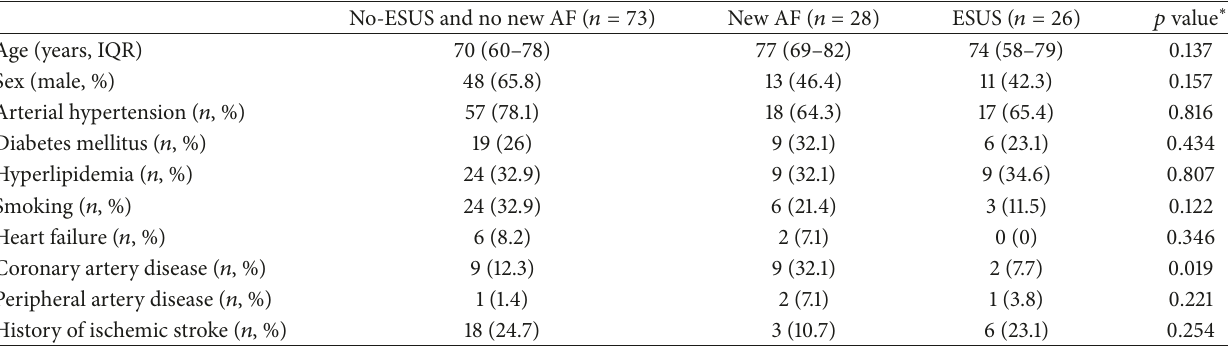
Table 1: Baseline characteristics ( 𝑛 = 127 ).